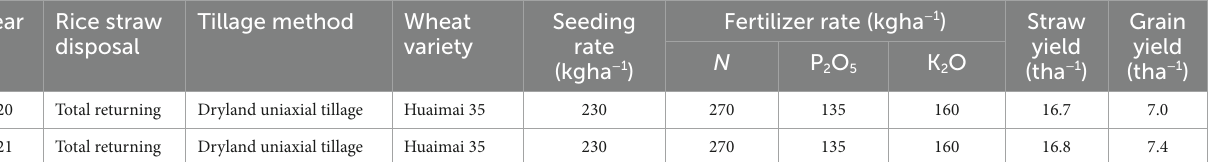
TABLE 1 Wheat planting information at experiment site in 2020 and